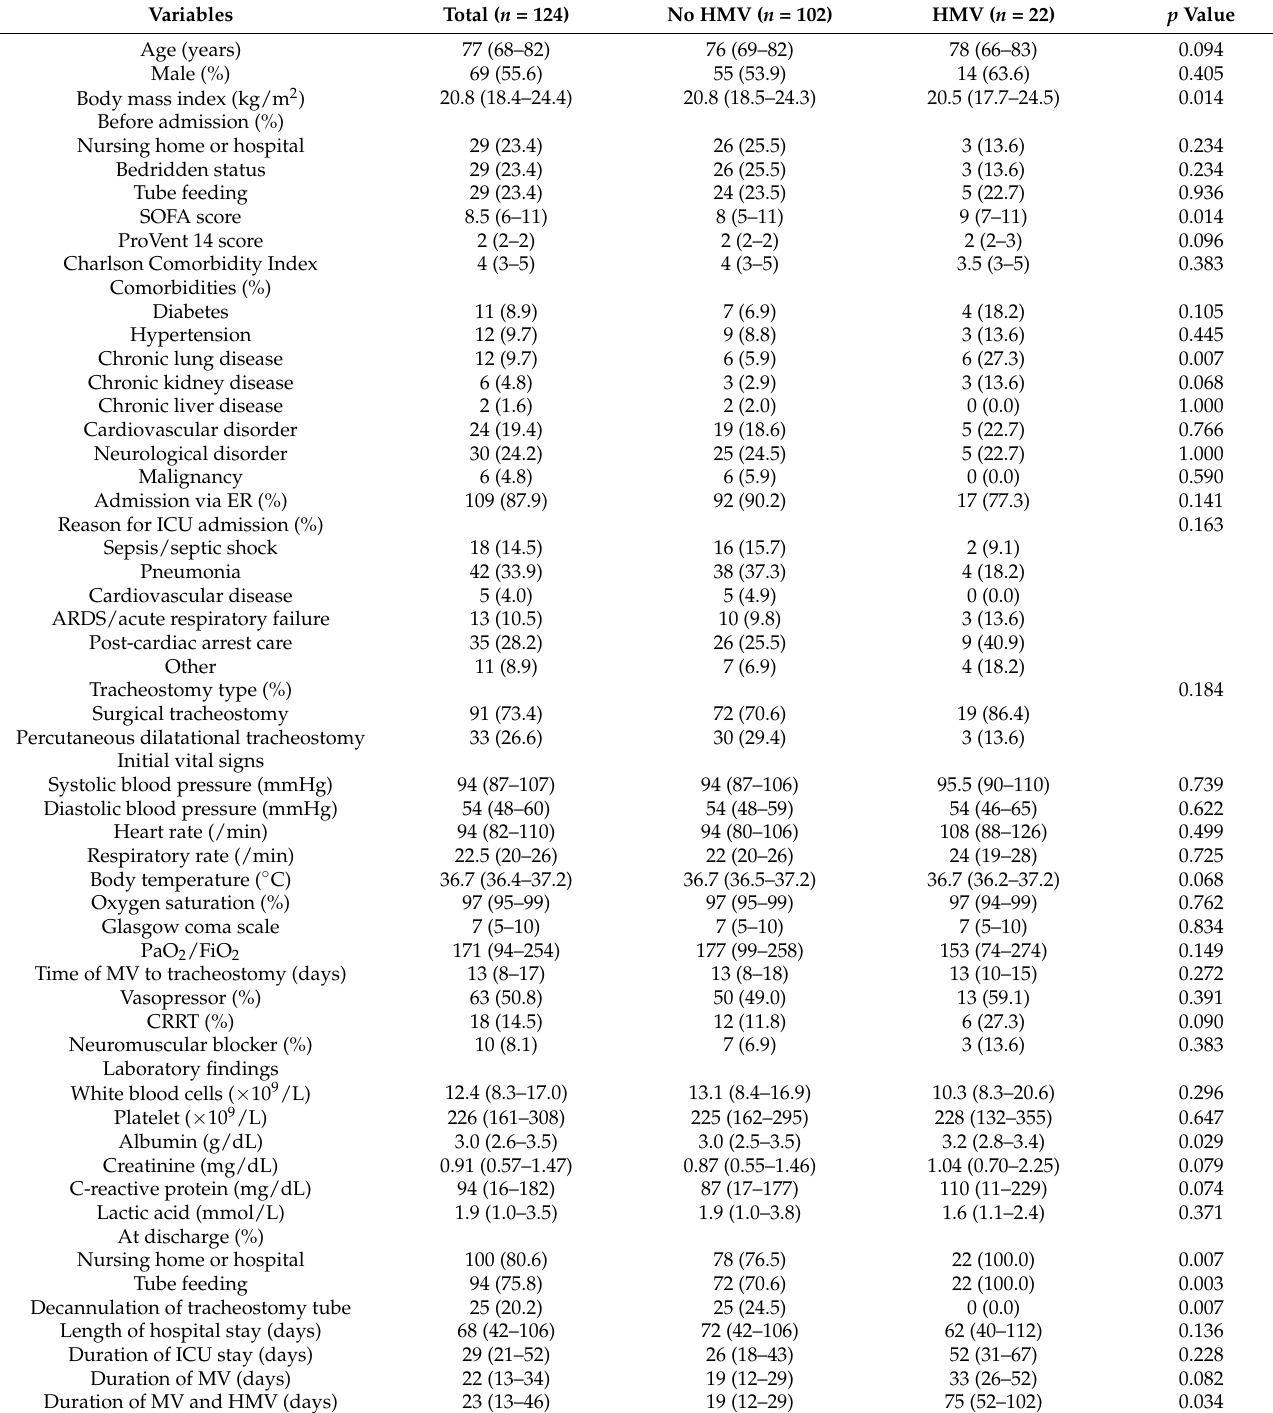
Table 1. Baseline characteristics of the mechanically ventilated patients who received a